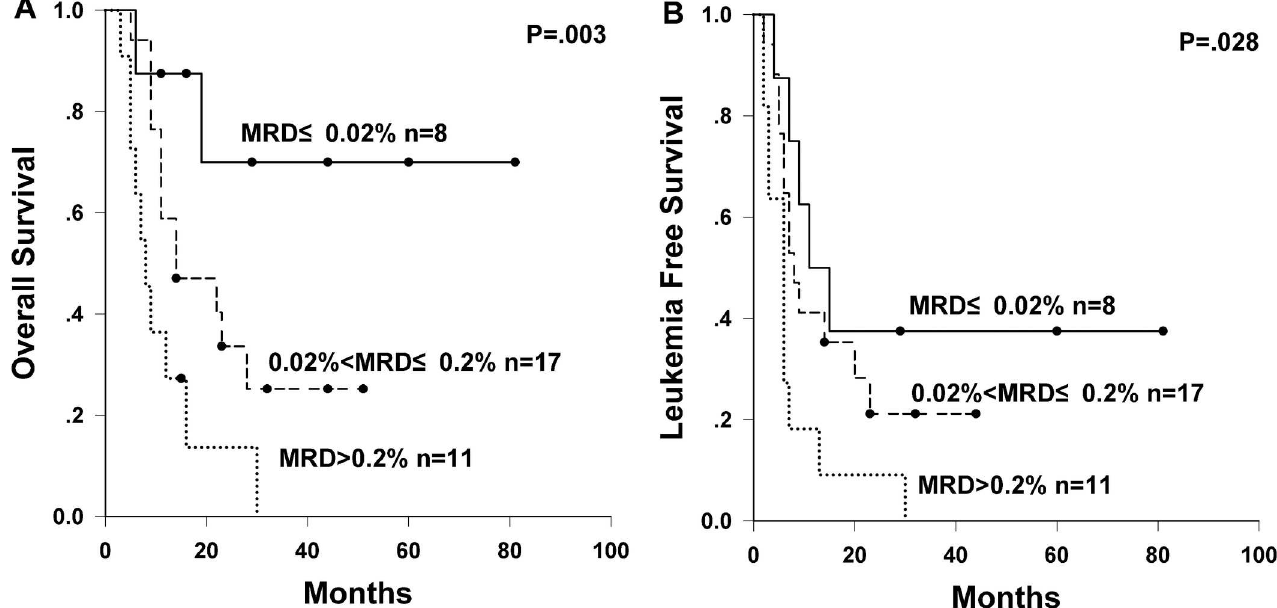
Fig 2. Survival of subgroups stratified by MRD at CR1 in the chemotherapy arm. (A) OS and (B) LFS of subgroupsstratified by MRD at CR1 in the chemotherapy arm.